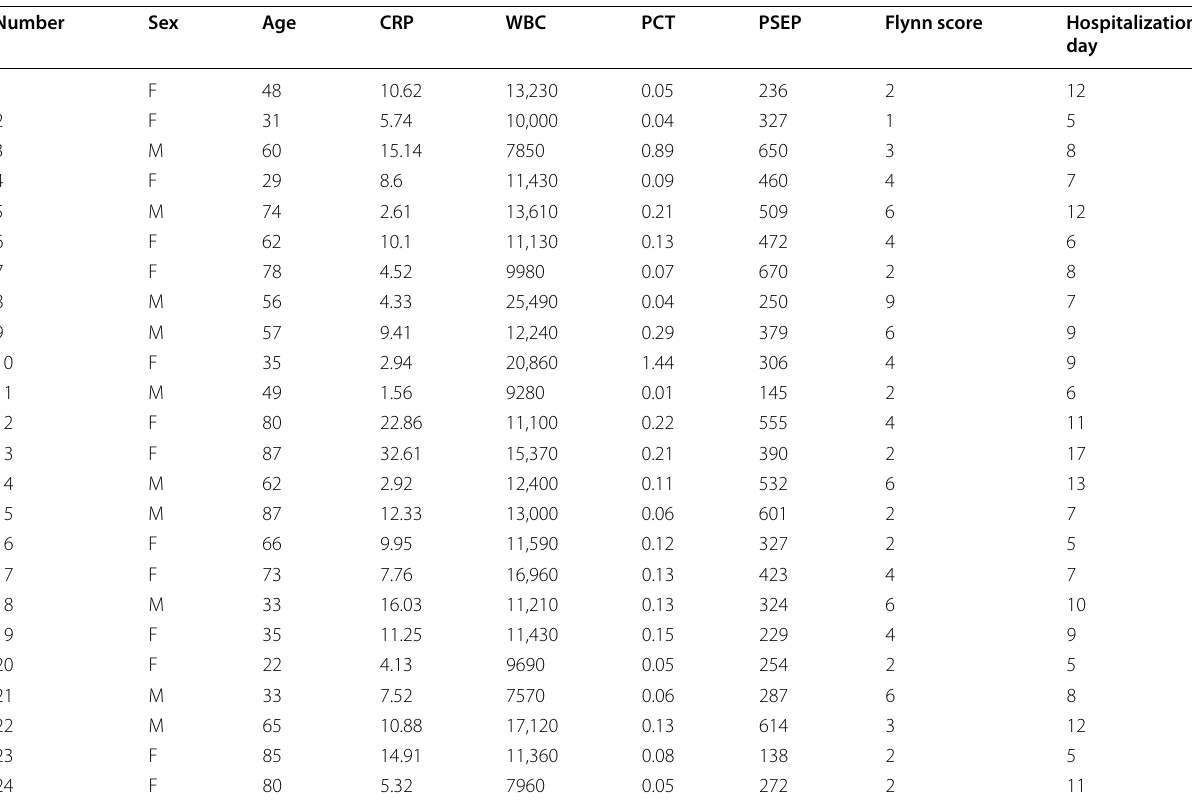
Table 2 Characteristics of study subjects (group 2: non‑sepsis) Number